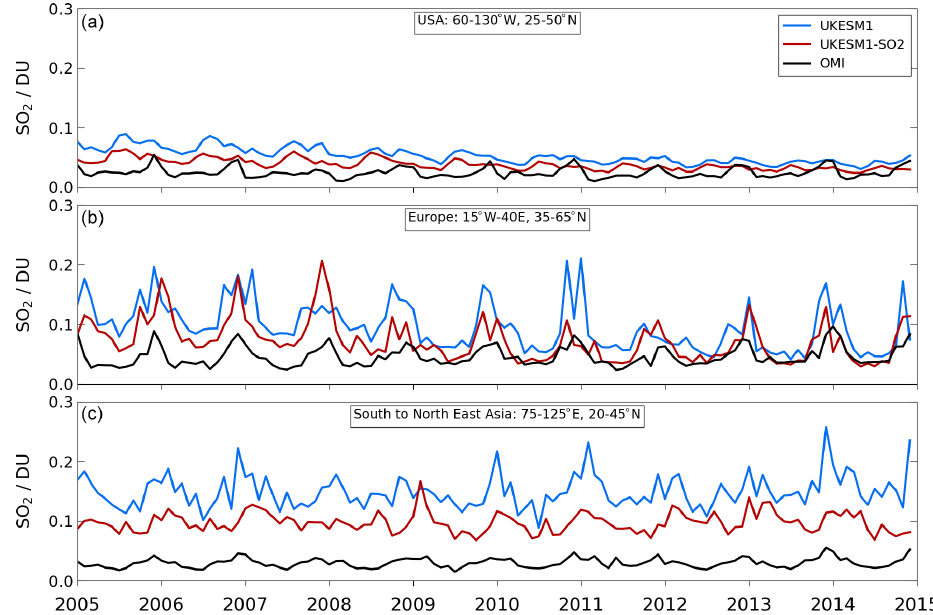
Figure 9. Median total column SO 2 calculated for 2005–2014 for USA (a) , Europe (b) , and South to North-east Asia (c) . Total column SO 2 is in Dobson